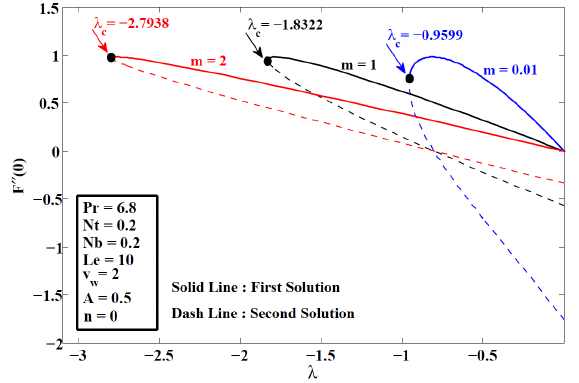
Figure 2: Variation of f (cid:48)(cid:48) (0) with the shrinking parameter λ for differ- ent values of first-order slip parameter m .